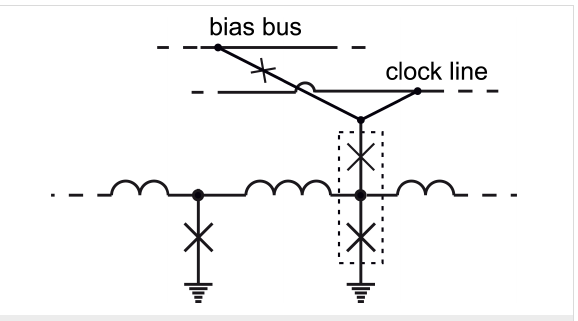
Figure 6: eSFQ power supply scheme. The dotted rectangle marks the decision-making